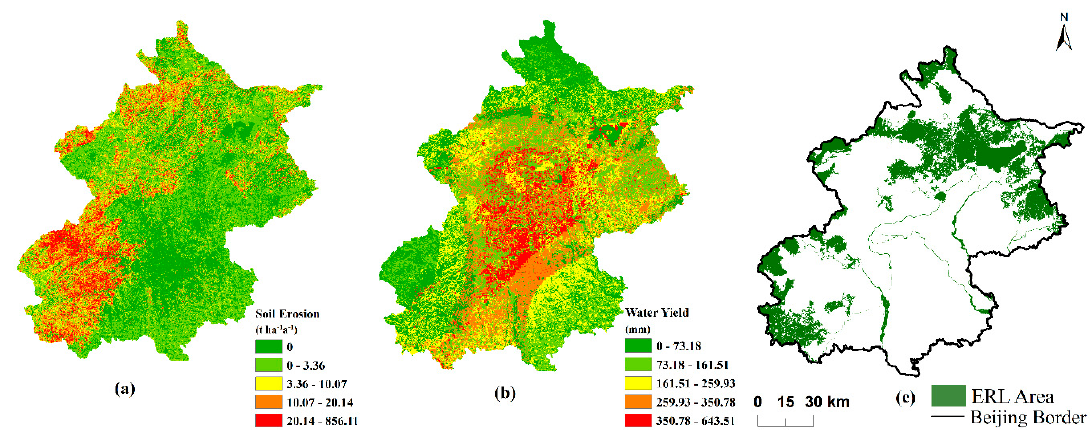
Figure 2. Distribution of soil erosion ( a ), water yield ( b ) in Beijing and Beijing ERL areas( c ).